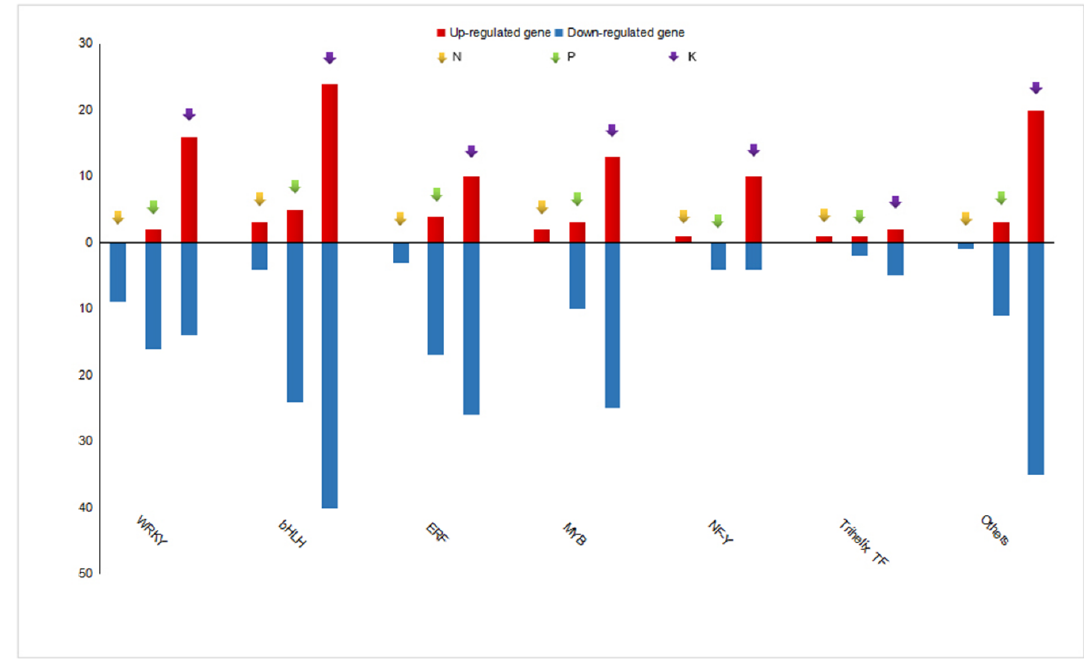
Figure 7. Distribution of up-regulated and down-regulated genes encoding transcription factor families in response to N, P, and K starvation. Each bar shows the number of members of the transcription factor family, with up-regulation in red and down-regulation in blue under N, P, and K starvation.